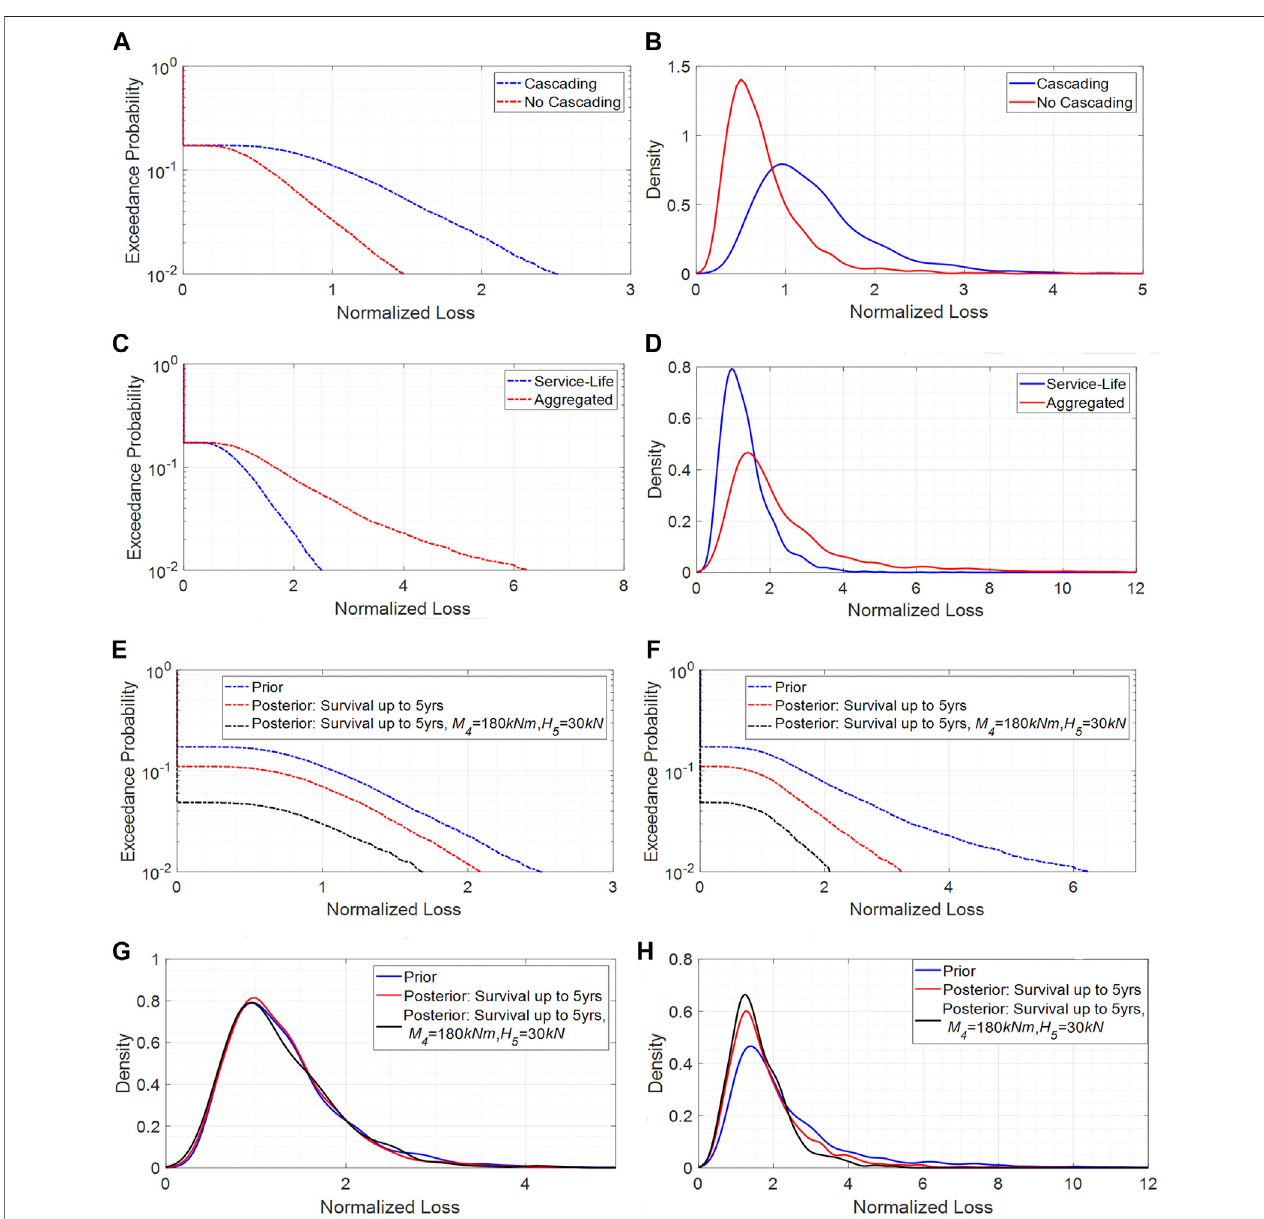
FIGURE 11 | (A) Variation of exceedance probability corresponding to its normalized loss with and without the consideration of the effect of cascading failure, (B) conditionaldistributionofthenormalizedlossgivenatleastoneofthetwoframeshavedamaged,forbothsetsofanalysiswithandwithoutconsideringcascadingeffect. (C) Comparison of the exceedance probability of normalized service-life loss and aggregated loss at the end of 15 years, (D) conditional distribution of the normalized service-life loss and aggregated loss given that at least one of the two frames have damage at the end of 15 years. The prior and posterior variation of exceedance probabilitycorrespondingtoits (E) normalizedservice-lifelossand (F) normalizedaggregatedlossattheendof15 years.Theconditionalpriorandposteriordistributions of the (G) normalized service-life loss and (H) normalized aggregated loss given that at least one of the two frames have damage at the end of 15 years.